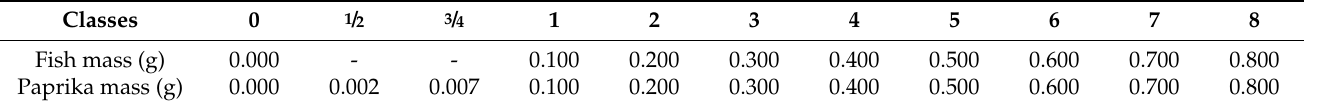
Table 1. Concentration samples (fish feed and paprika mass) used for each